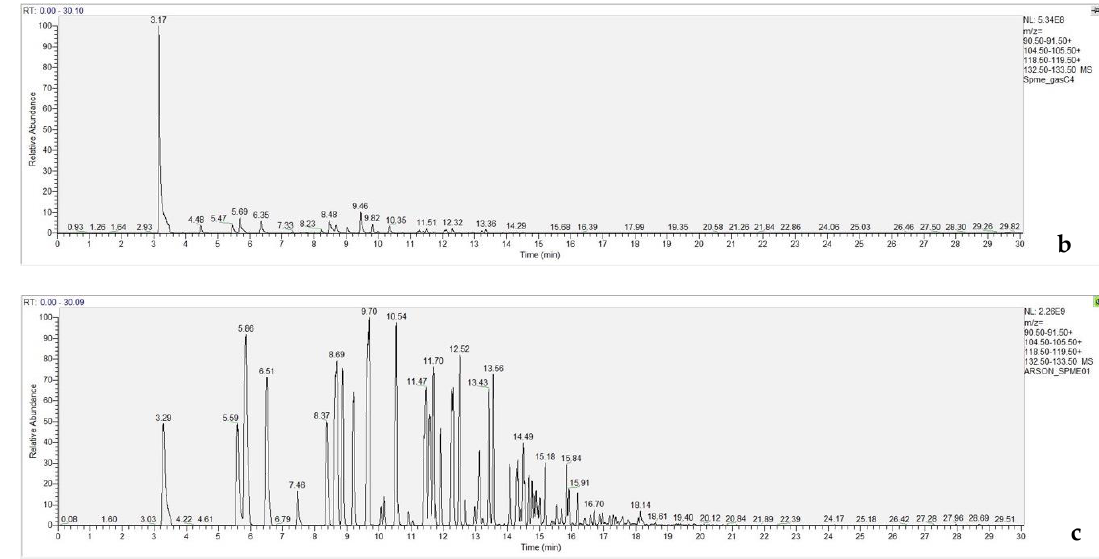
Figure 11. Extracted aromatic (alkylbenzenes) profiles of ( a ) carpet #3 burned without ILs; ( b ) carpet#1 burned with gasoline; and ( c ) neat gasoline.